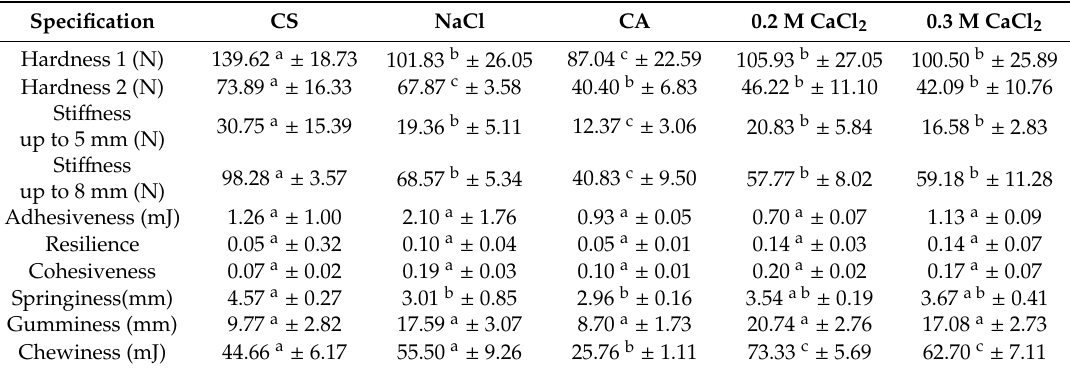
Table 4. Texture parameters of horse meat after 96 h of cold storage ( x ±